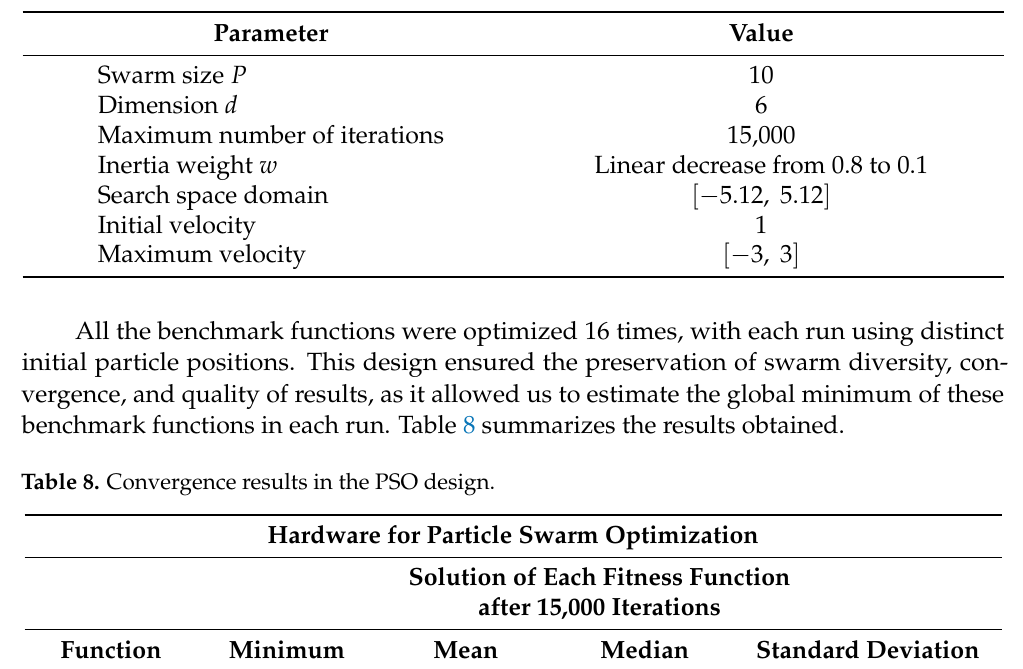
Table 7. Parameters used in the experiment to validate the proposed digital tent map as a pseudo- random number generator in a hardware architecture for particle swarm optimization.